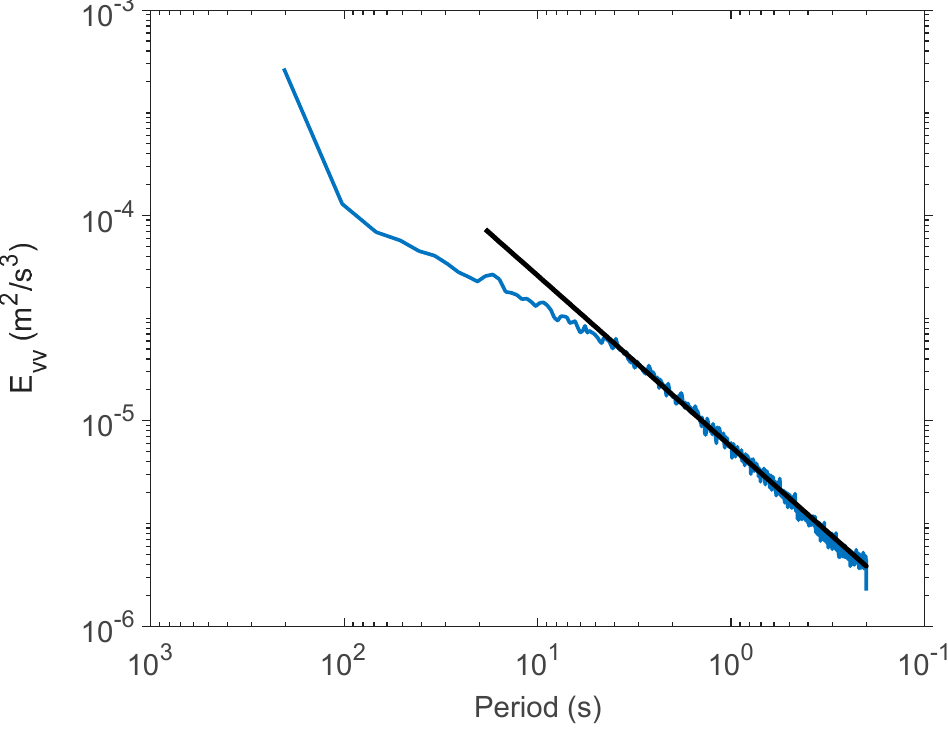
Figure 10. Average energy density (Evv) for all bursts with an average along channelcurrent speed > 0.10 m/s. The solid line (–5/3 slope) denotes the inertial subrange. The energy containing eddies occupy the region to the left of the inertial subrange.